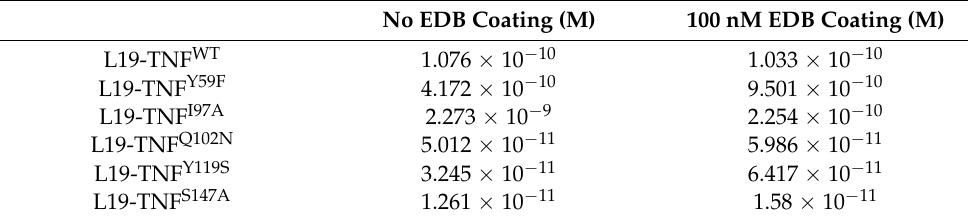
Values were obtained by measuring viable cells after incubation with each molecule in the presence or absence of EDB coating ( n = 3).